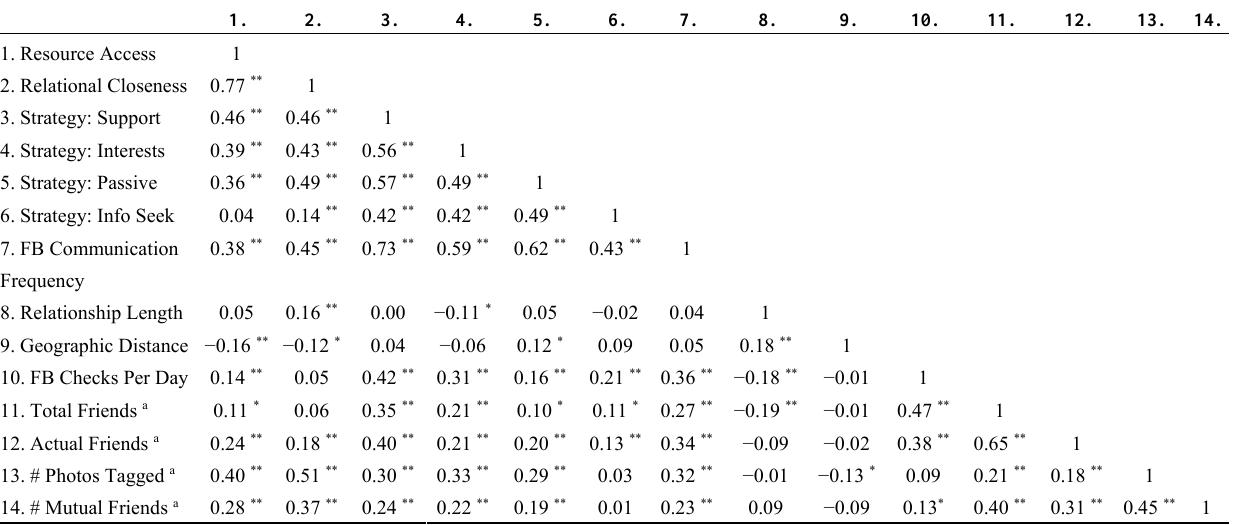
Table 4. Correlation Matrix of Variables Included in